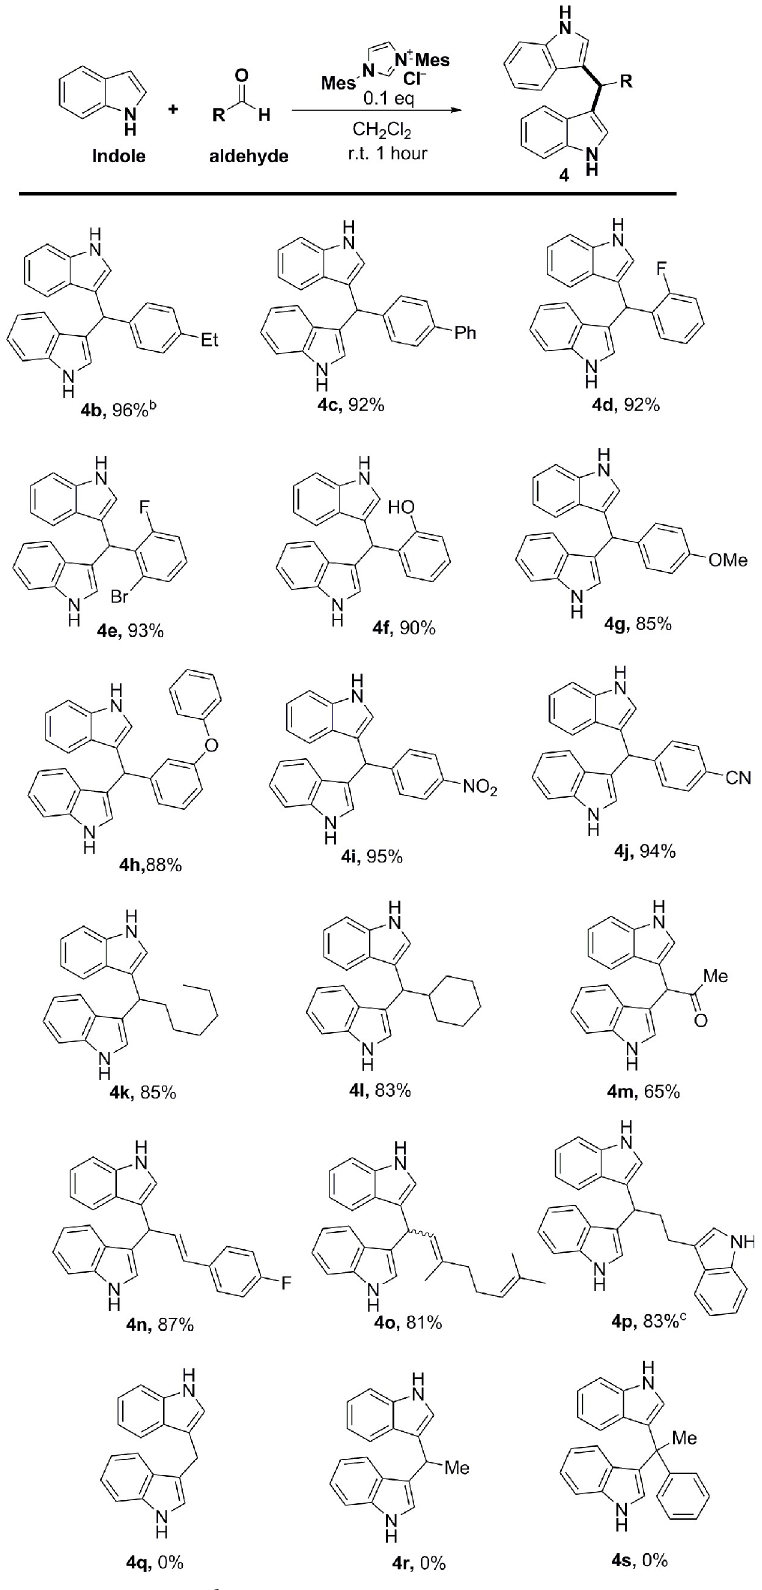
Fig 4. Scope of aldehydes a